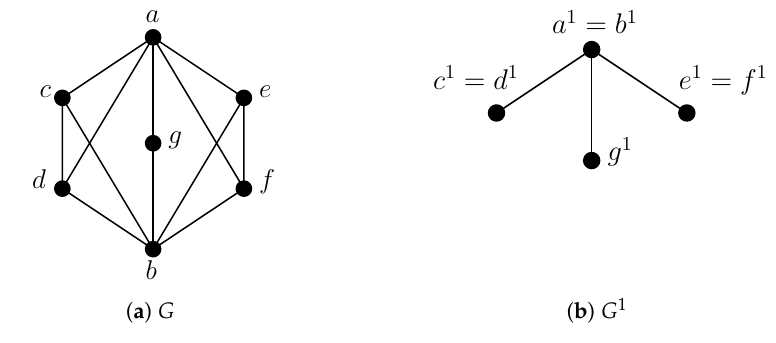
Figure 10. A cograph G and its twin graph G 1